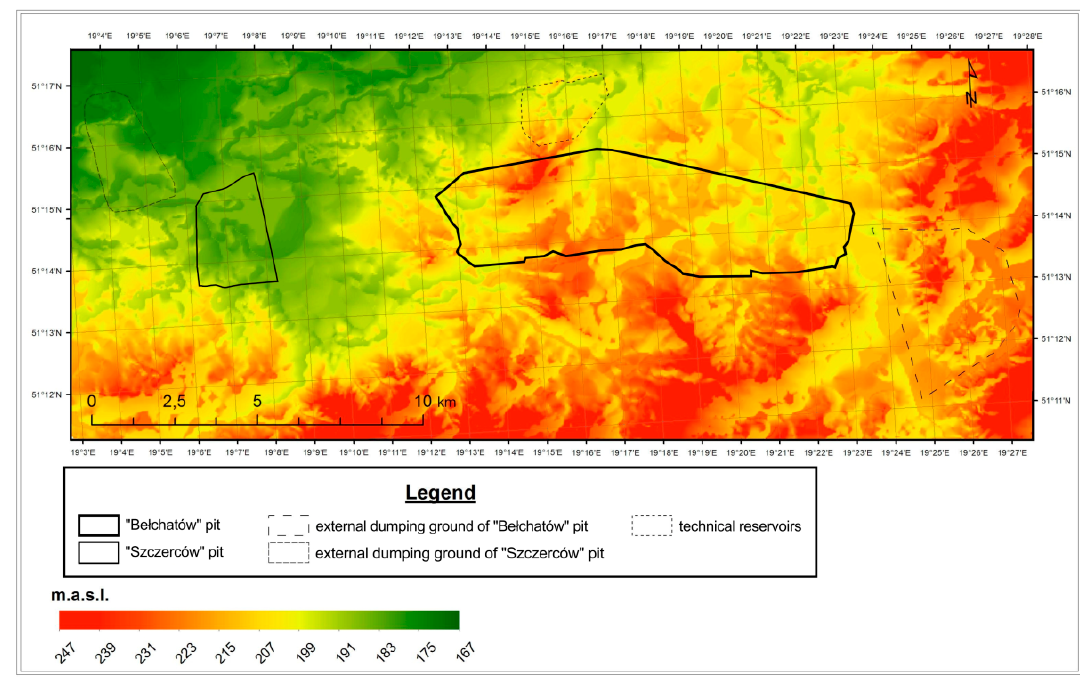
Figure 2. Digital Elevation Model of the analyzed area from the pre-investment period—two-dimensional view using a standard hypsometric color ramp and shaded topography with the z-factor value of 1. Source: Own elaboration.